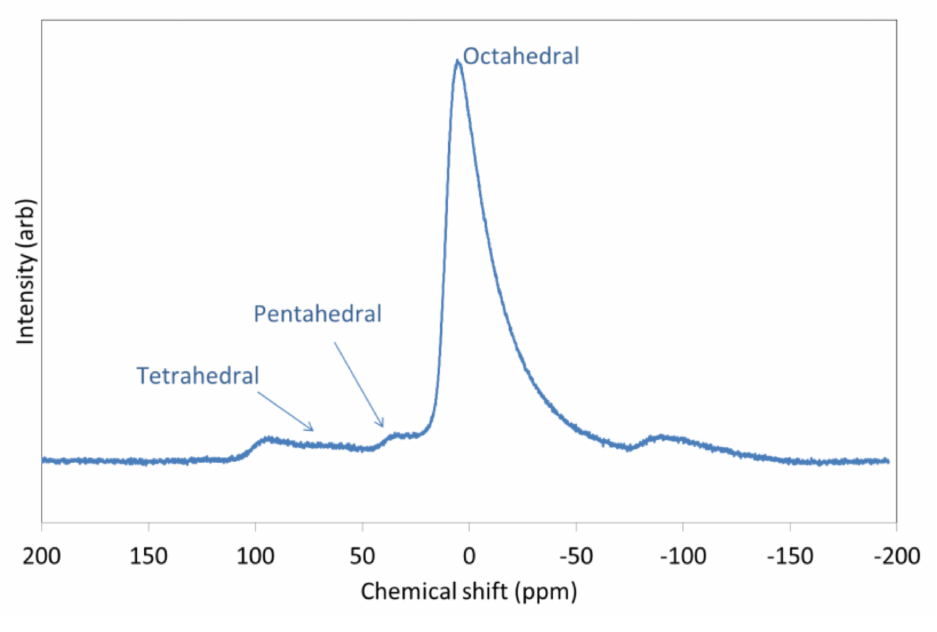
Figure A2. 27 Al MAS NMR spectrum of the amorphous aluminium hydroxide waste.